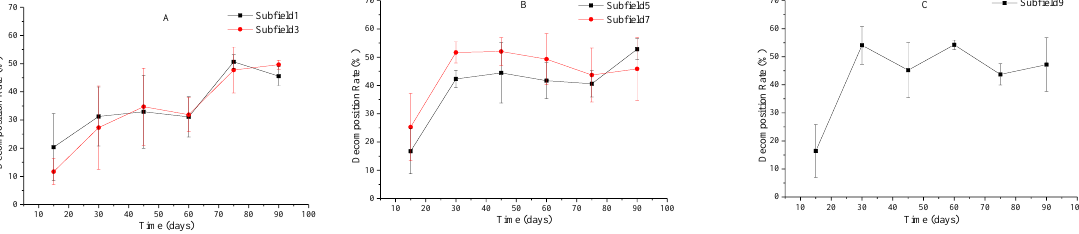
Figure 7. Changes in the wheat straw decomposition rate over time with different tillages. Note: ( A )—Plowing; ( B )—Dry rotary; ( C )—Wet Rotary.